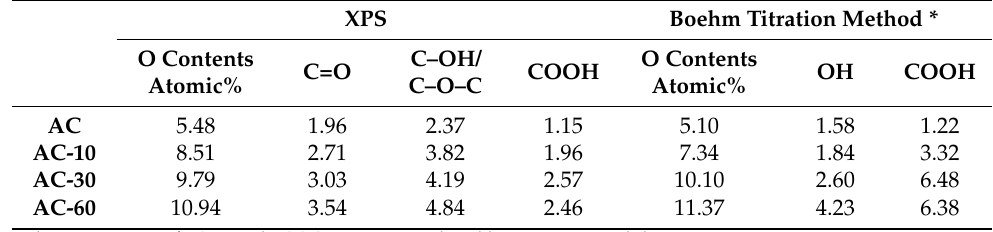
analysis and the Boehm titration